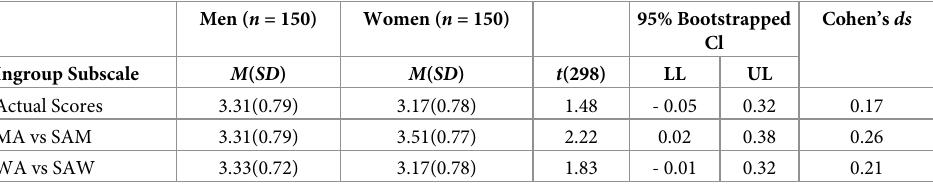
Table 4. Comparison of gender on actual and stereotype scores on ingroup subscale (N =